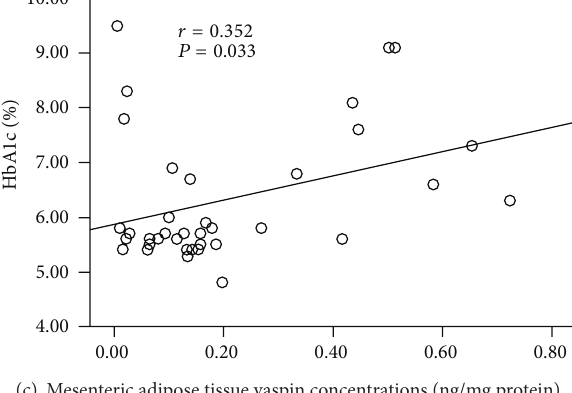
Vaspin can increase glucose uptake by adipocytes [21].